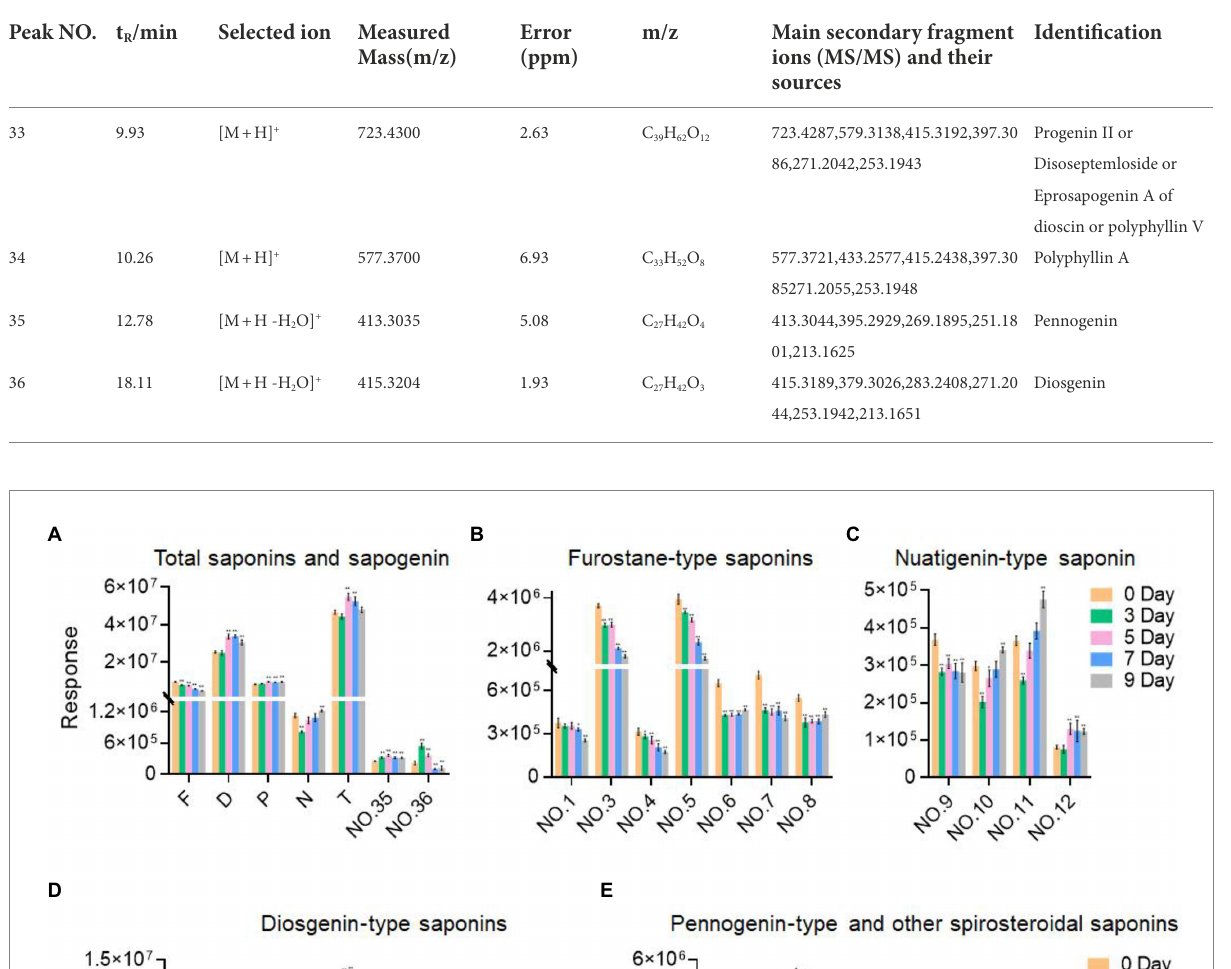
(Supplementary Table S2). The synthesis of steroidal saponins can be divided into three stages: sterol synthesis, aglycon